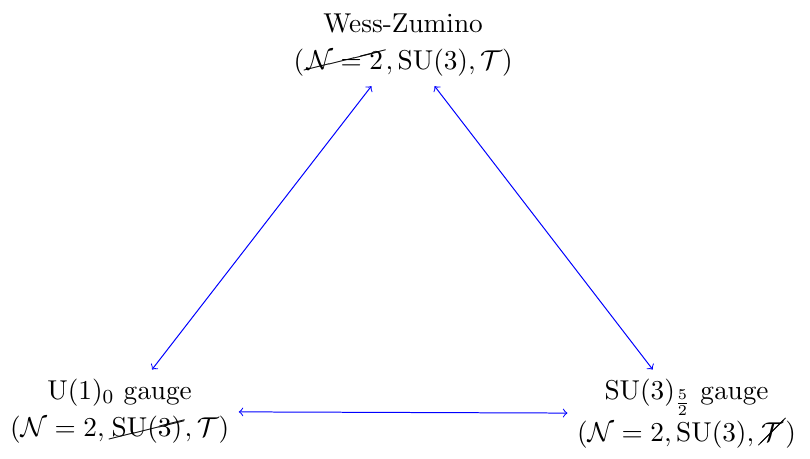
Figure 1 . The models depicted in this figure are dual to each other. For each model we indicate which symmetries are manifest in the UV action and which are not (crossed